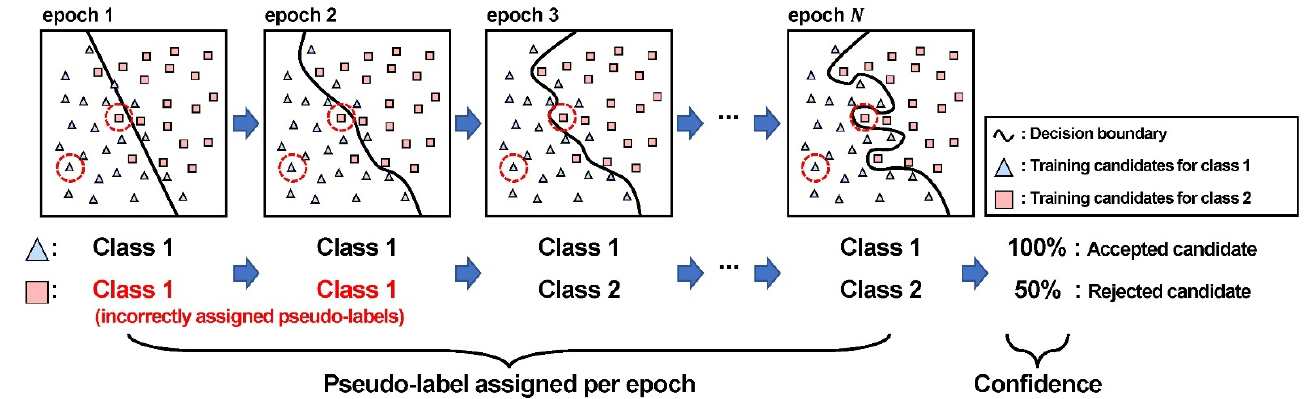
Figure 3. The illustration of the first constraint on updating the initial training candidates using uncertainty information from DANN.